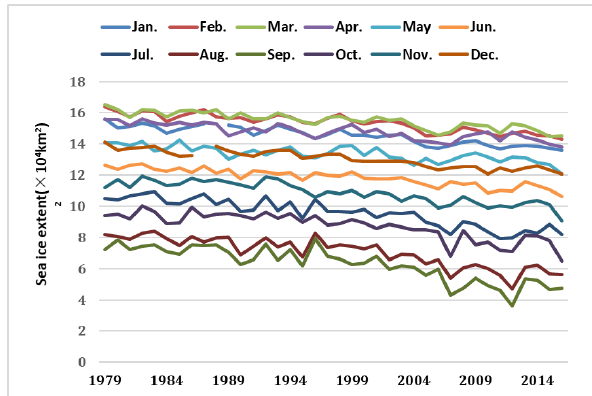
The change cycles of these four active regions are further investigated based on wavelet analysis. The results are shown in Figure 7. Based on the wavelet graph of real part coefficient and energy significant area in Figure 7(a), it is indicated that there is a cyclical swing in time scale of 6 ~ 8 years and 20 ~ 25 years during the period from 1979 to 2016 in Barents. At the same time, the periodic oscillation is hidden under the time scale of 12~17 years from 1979 to 1997. Similarly, we can find a cyclical swing in the time scales of 20 ~ 23 years and 26 ~ 28 years in Greenland. And there is hidden the periodic oscillation in time scale of 13 ~ 17 years from 1979 to 2000. In Baffin & Lawrence, there are periodic oscillations at the time scale of 25~30 years in the whole time domain from 1979 to 2016. Meanwhile, in the period from 1979 to 1995, the period under the time scale of 12~15 years is hidden, but the oscillation is less significant. Finally, there are periodic oscillations at the time scale of 13~18 years in the whole time domain from 1979 to 2016 in